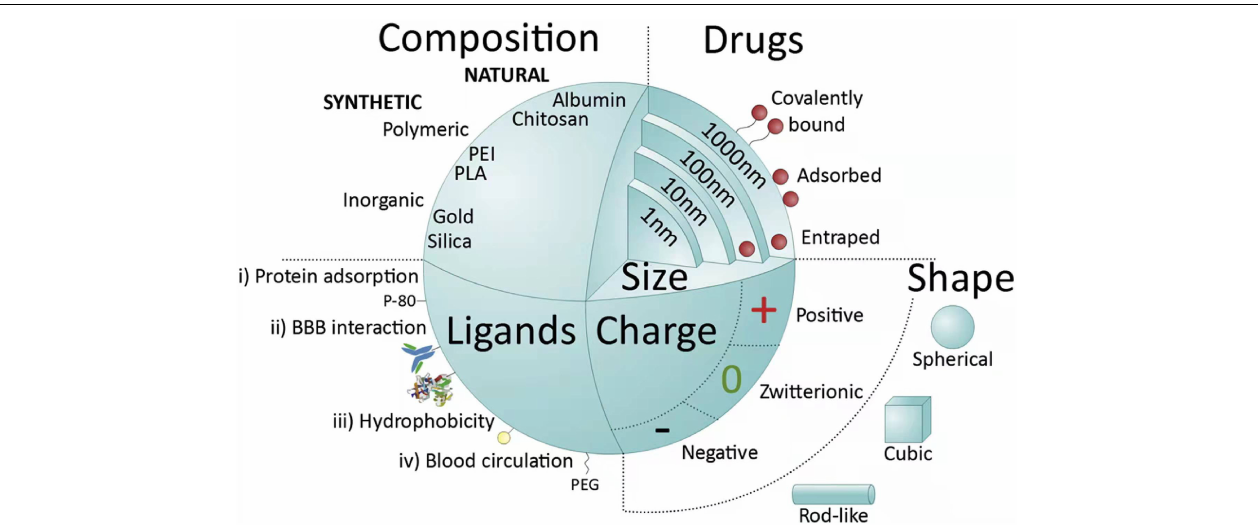
FIGURE 3 | Main nanoparticle (NP) features influencing systemic delivery and blood brain barrier (BBB) passage. NPs can be classified into natural, when molecules such as proteins (albumin), polysaccharides, chitosan, among others are used, or synthetic. Synthetic NPs can be made of very common polymers such as poly(lactic-co-glycolic acid) (PLGA), poly(ethylenimine) (PEI), polyesters [poly(lactic acid)] (PLA), or from inorganic agents like gold, silica or alumina. NPs can vary in their size (1–1000 nm) and are able to deliver drugs into cells by entrapping, adsorbing or covalently bounding them. NPs can assume different shapes (spherical, cubic, and rod-like) and charges (negative, zwitterionic, and positive); negatively charged spheres are widely used in intravenous applications. Another important feature of NPs is the possibility of functionalization with different types of ligands. Ligands are distributed into four major categories: (i) capable of mediating protein adsorption [e.g., poly(sorbate) 80 (P-80)]; (ii) able to interact directly with the BBB (e.g., transferrin proteins, antibody or peptides); (iii) capable of increasing hydrophobicity (e.g., amphiphilic peptides); and (iv) able to improve blood circulation [e.g., poly(ethylene glycol) (PEG)] (Saraiva et al.,